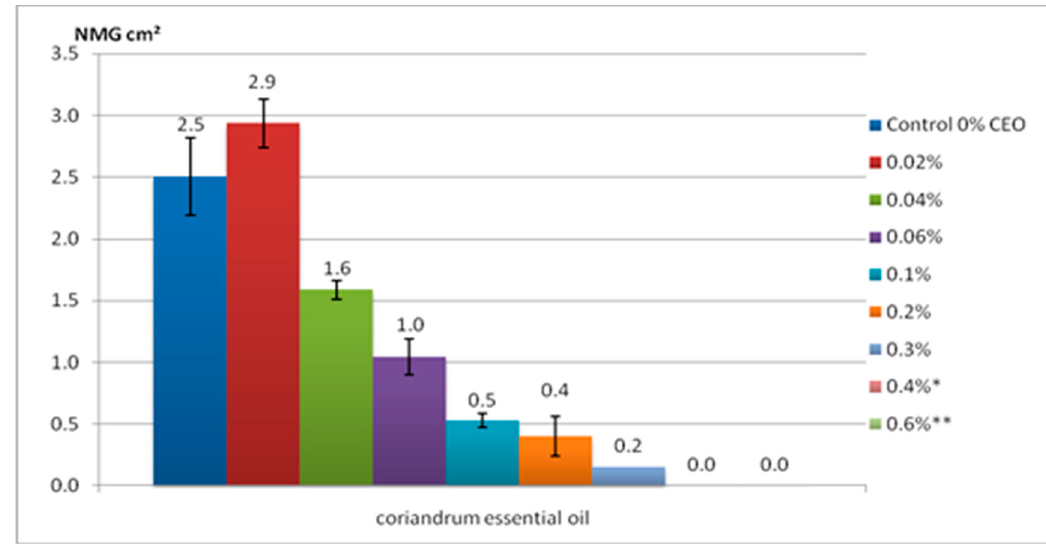
Figure 1. The new mycelium growth areas (NMG) on the medium at different concentrations of coriander essential oil (CEO); * Minimal concentration with fungistatic effect (MCFs value); ** Minimal concentration with fungicide effect (MCFg value). Data are mean ± SD, n = 6.